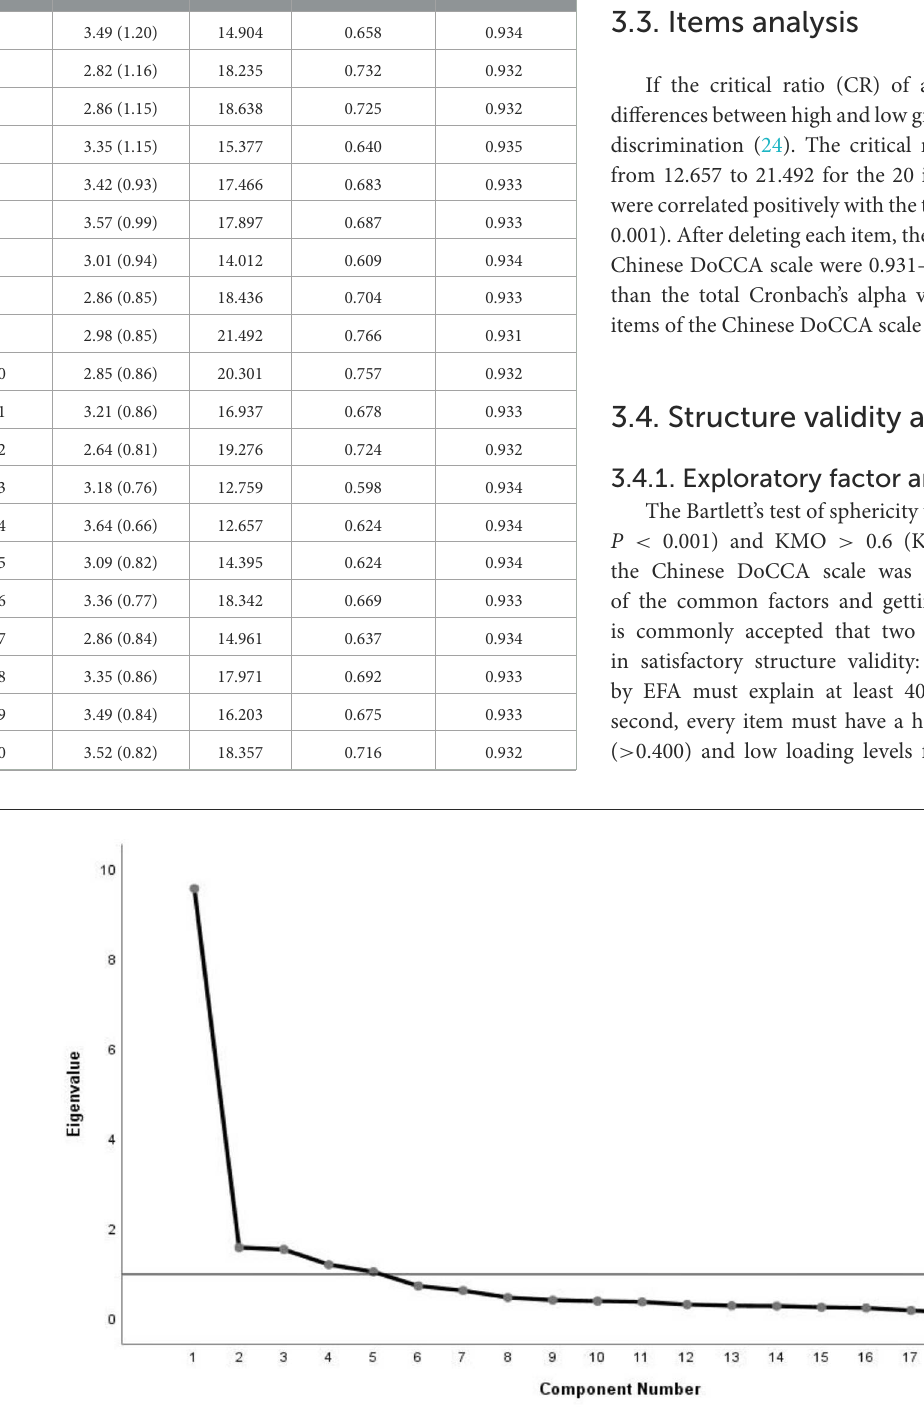
FIGURE3 Screen plot of exploratory factor analysis for Chinese DoCCA